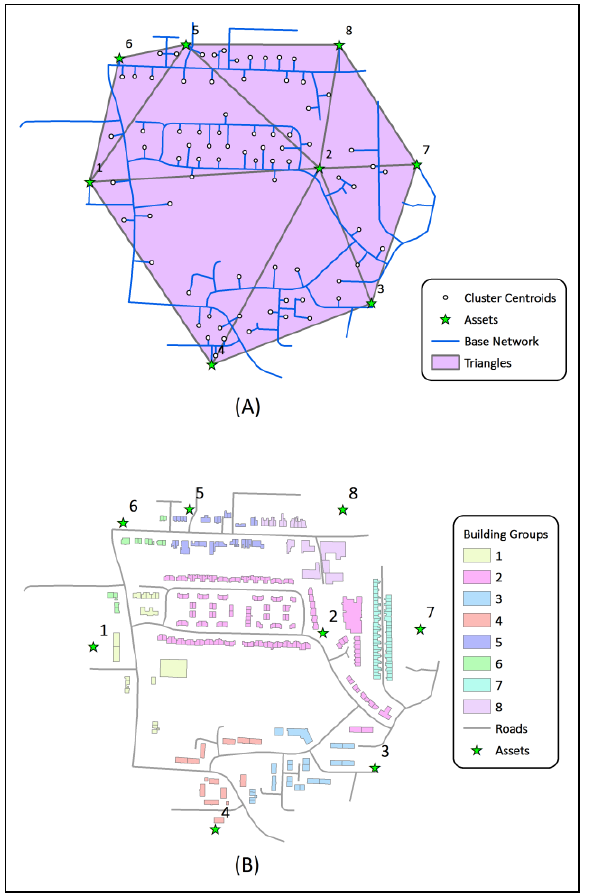
Figure 5. (A) Triangulation using asset points. (B) Result for topology generation step (Contains OS data © Crown copyright and database right 2018).